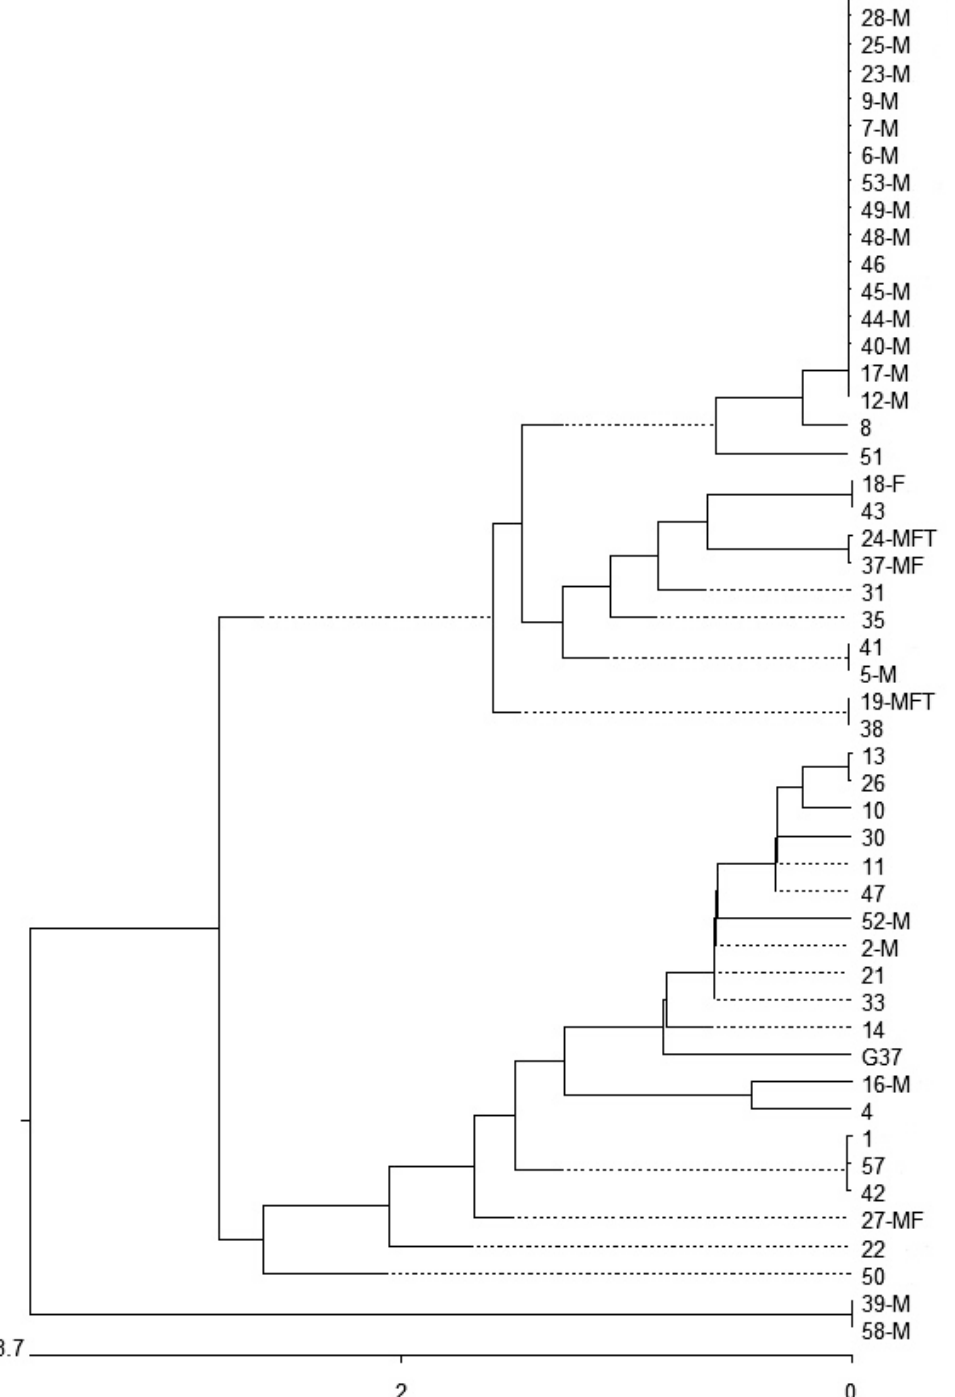
Figure 1. Similarity of partial mgpB sequences of type strain G37 and 54 M. genitalium clinical strains. M: strain with a macrolide resistance-associated mutation; F: strain with a fluoroquinolone resistance-associated mutation; T: strain with a tetracycline resistance-associated mutation. Bold and underlined: new types in comparison with the types described in Supplementary Table S1. Nucleotide substitution per 100